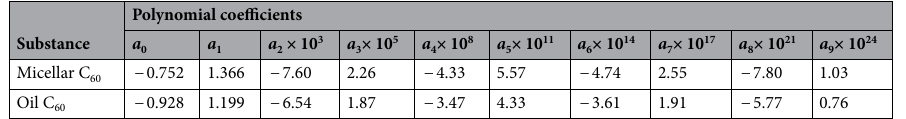
Table 3. Calculated ninth-order polynomial coefficients for predicted curves of concertation time experimental values according to Eq. 3.